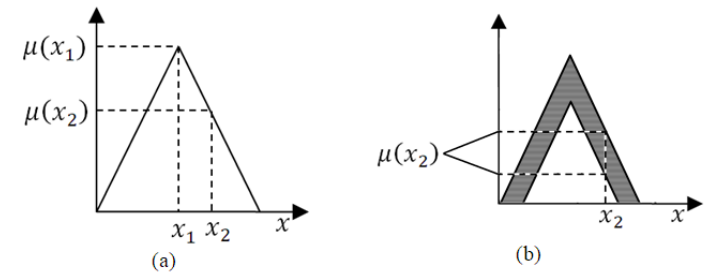
Figure 2. The type of fuzzy sets of the 1st ( a ) and the 2nd ( b )